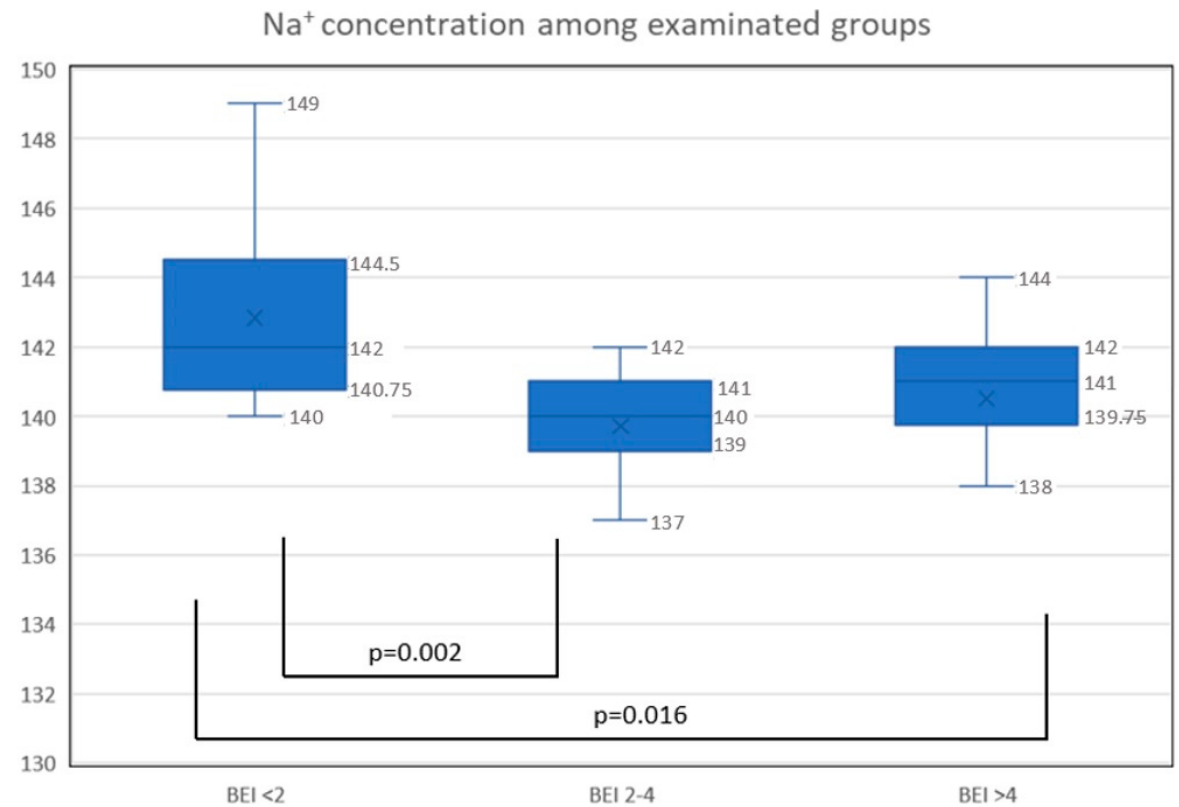
Figure 1. The concentration of sodium in examinated groups: nonbruxers (BEI < 2), mild bruxers (2 ≤ BEI < 4), and severe bruxers (BEI ≥ 4); Na + , sodium (mmol/L); p -value < 0.05 statistically significant. Table 2. Concentrations of electrolytes in the entire study group and in nonbruxers (BEI < 2), mild bruxers (2 ≤ BEI < 4), and severe bruxers (BEI ≥ 4).